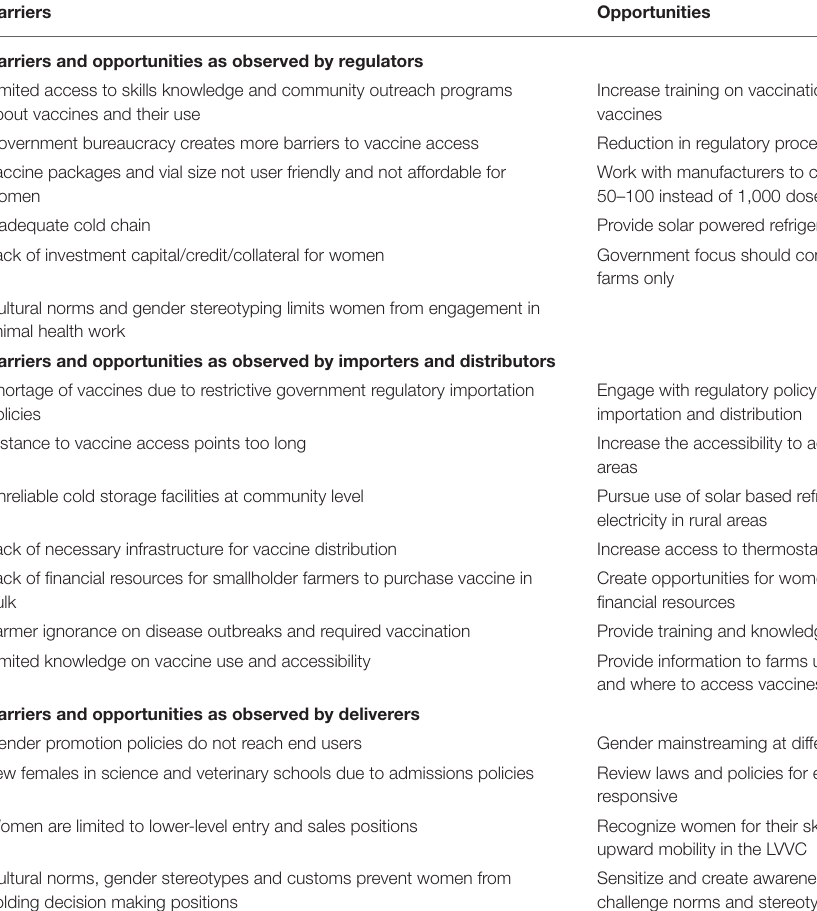
TABLE 2 | Barriers and opportunities as identified by LVVC